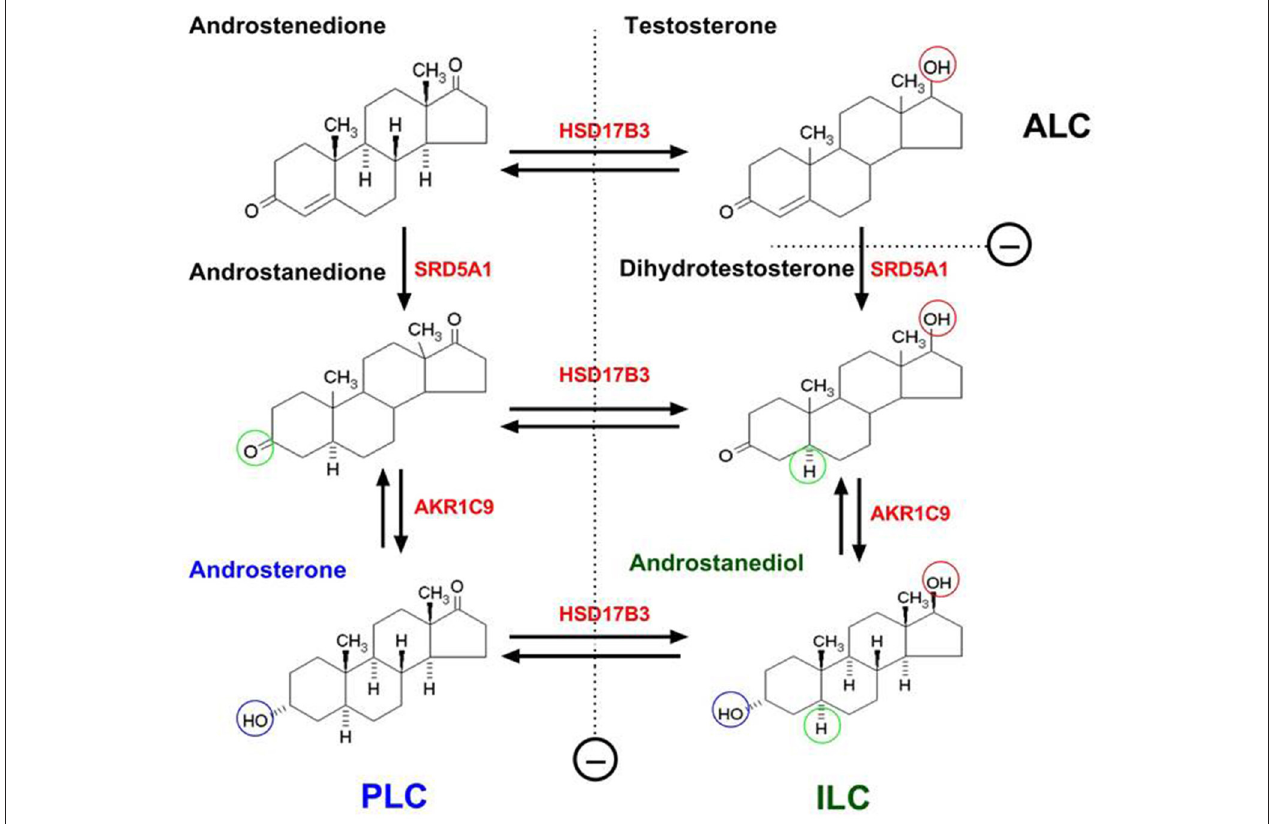
FIGURE 2 | The difference of progenitor, immature and adult Leydig cells in the products of androgen in rats due to their differential expressions of steroidogenic enzymes. PLC, ILC, and ALC represent progenitor, immature, and adult Leydig cells, respectively. PLC lacks of 17 β -hydroxysteroid dehydrogenase 3 (HSD17B3) but contains higher levels of 5 α -reductase 1 (SRD5A1) and 3 α -hydroxysteroid dehydrogenase (AKR1C9), thus producing primarily androsterone. ILC begins to express HSD17B3 and also contains SRD5A1 and AKR1C9, thus producing predominantly androstanediol. ALC secretes mainly testosterone due to the silence of SRD5A1. SRD5A1 is a unidirectional enzyme. Other steroidogenic enzymes are